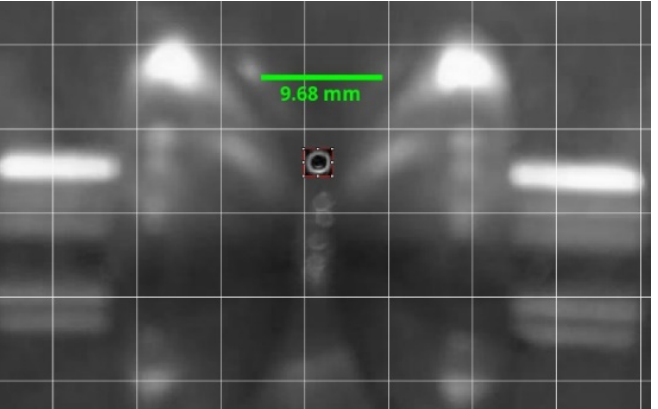
Figure 23. Improvement in the definition of the bubble using the ImageJ program for measuring the diameter.